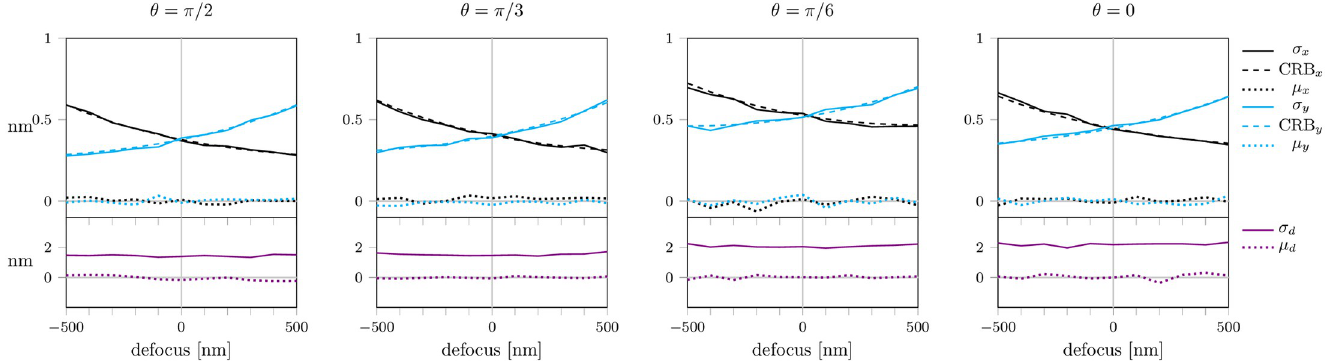
Fig 4. Localization errors in the presence of astigmatism. We fitted the position and defocus ( x , y , d ), while the dipole orientation ( θ , ϕ ) was assumed to be known exactly. Background noise was set to b = 0. All other parameters were identical to those of Fig 2. A list of all simulation parameters is given in S1 Table in S1 File.